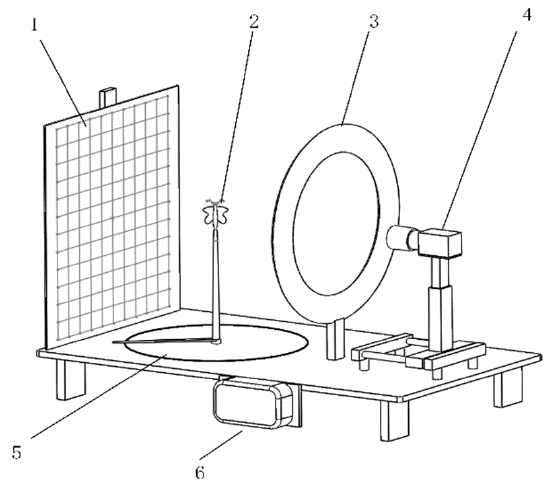
Figure 4. Image acquisition platform. 1. Standard square paper. 2. Insect specimen. 3. Light source. 4. Camera. 5. Rotating platform. 6. Single chip.